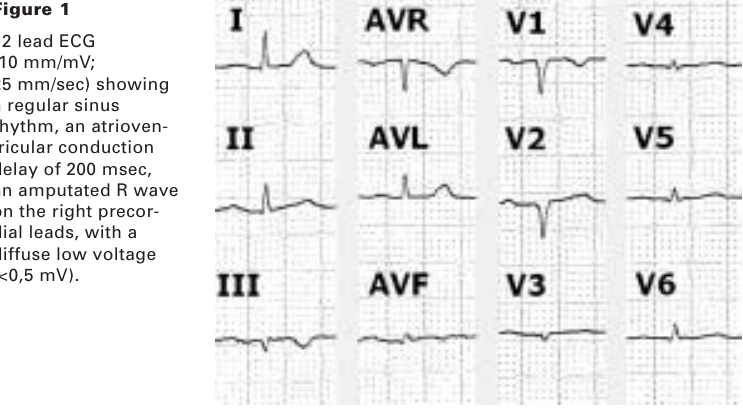
Figure 2 Apical four chamber view of a two dimen- sional echocardio- gram, showing a moderate thickening of the left ventricular walls (interventricu- lar septum 14 mm: arrowhead), with a mild granular sparkling only in the right ventricular por- tion of the septum ( [ ), and a systolic ante- rior movement of the cord of the postero- medial papillary mus- cle of the anterior mitral leaflet (SAM: white arrow). LV = left ventricle LA = left